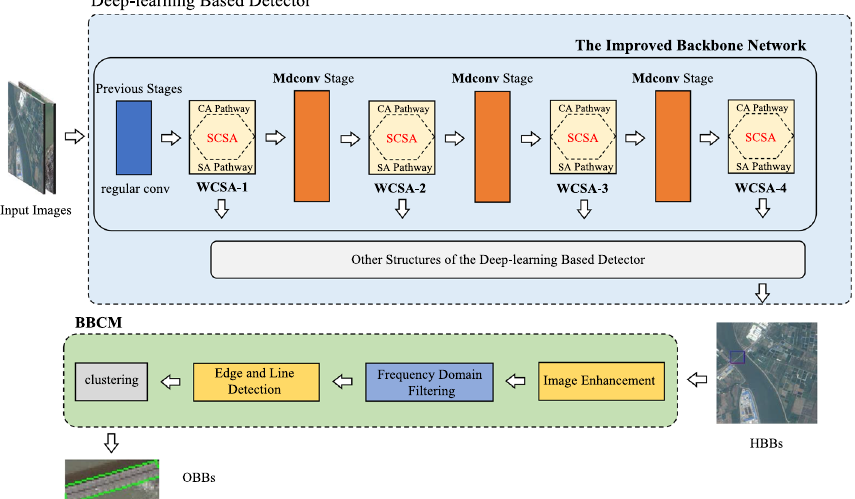
Fig. 2 Overview of the proposed scheme for bridge-over-water